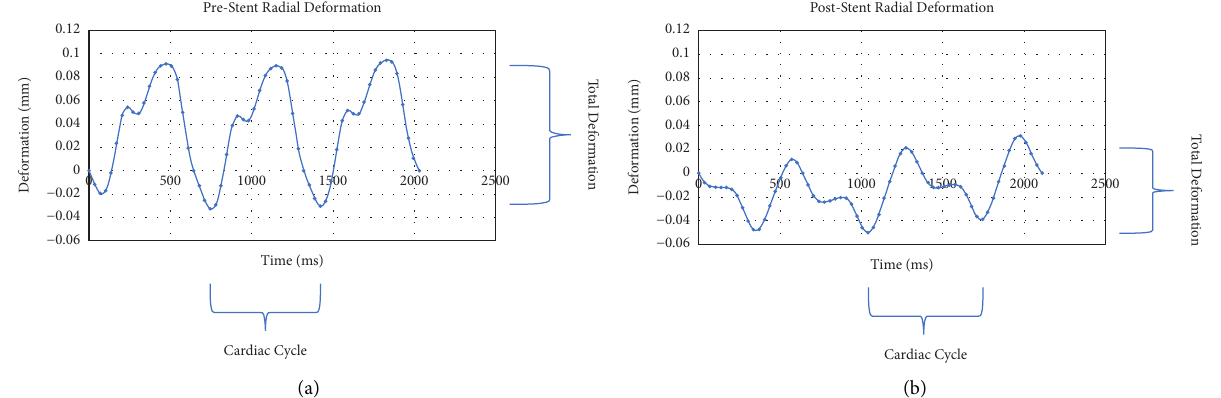
Figure 3: Pre and poststent coronary artery vessel wall radial deformation: (a) Prestent and (b) Poststent. Representative example of radial deformation over time in (a) prestent and after (b) poststent implantation. Poststent delivery, total coronary vessel radial deformation is attenuated compared to prestent